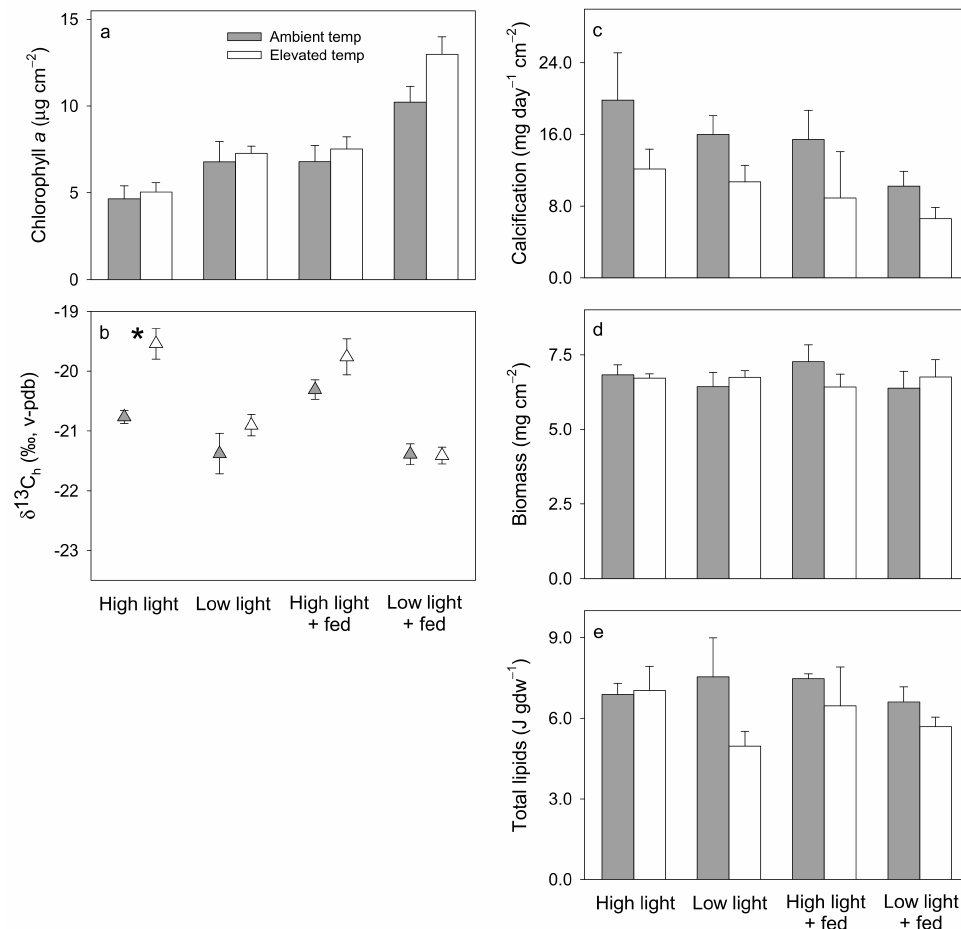
Figure 5. Stylophora pistillata average ( ± 1 SE) ( a ) chlorophyll a , ( b ) δ 13 C h , ( c ) calcification, ( d ) biomass, and ( e ) total lipids, under ambient temperature (25 ◦ C, solid bars) and elevated temperature (30 ◦ C, open bars) within high light (300 µ mol photons m − 2 s − 1 , unfed), low light (150 µ mol pho- tons m − 2 s − 1 , unfed), high light + fed (300 µ mol photons m − 2 s − 1 , fed), and low light + fed (150 µ mol photons m − 2 s − 1 , fed) treatments. Asterisks indicate significant differences between ambient and elevated temperature treatments within each light and feeding treatment combination. N = 5 for all averages. Significant effects from corresponding ANOVAs in Table